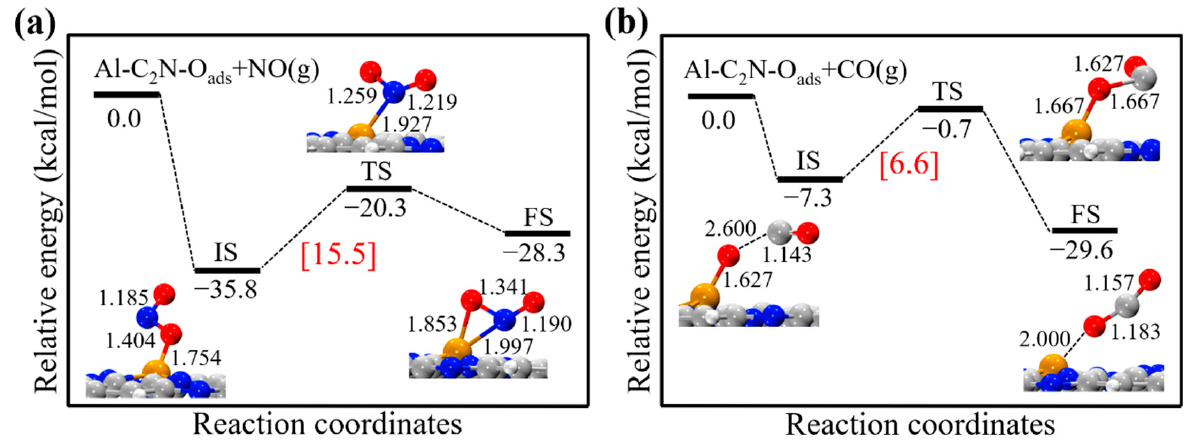
Figure 7. The energy profiles and corresponding structures for the step of ( a ) O ads + NO → NO 2 and ( b ) O ads + CO → CO 2 on Al-C 2 N, respectively. All bond lengths are in Å.